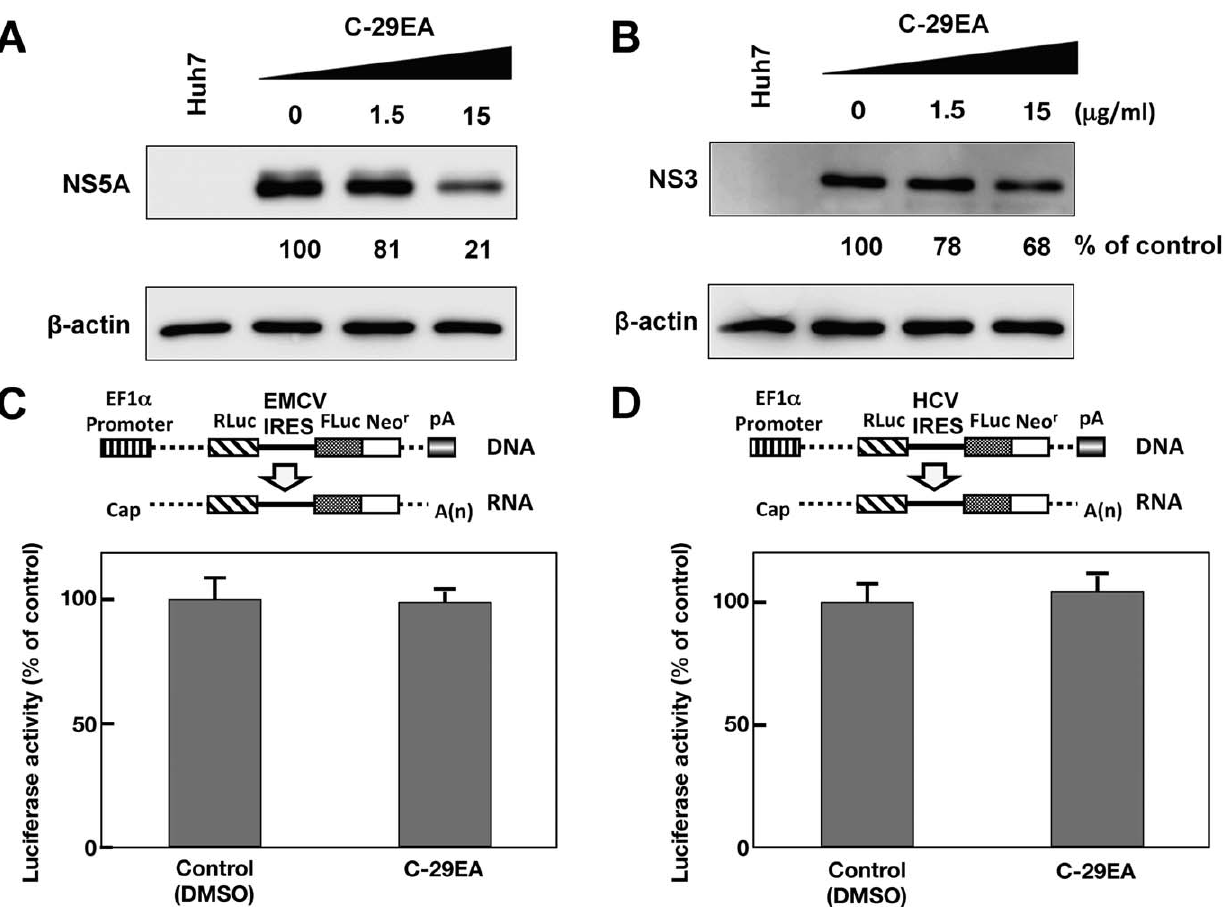
Figure 3. Effect of C-29EA on expression of viral proteins in replicon cell lines. The Huh7 replicon cell lines derived from genotype 1b (A) and 2a (B) were incubated with C-29EA at 37 u C for 72 h. The treated cells were harvested and then subjected to Western blotting. Treatment with DMSO corresponds to ‘0 9 . The bicistronic gene is transcribed under the control of the elongation factor 1 a (EF1 a ) promoter. The upstream cistron encoding Renilla luciferase (RLuc) is translated by a cap-dependent mechanism. The downstream cistron encodes the fusion protein (Feo), which consists of the firefly luciferase (Fluc) and neomycin phosphotransferase (Neo r ), and is translated under the control of the EMCV IRES (C) or HCV IRES (D). The Huh7 cell line transfected with the plasmid (each above the panel in C and D) was established in the presence of G418. The cells were incubated for 72 h without (control) and with 15 m g/ml of C-29EA. Firefly or Renilla luciferase activity was measured by the method described in Materials and Methods and was normalized by the protein concentration. F/R: relative ratio of firefly luciferase activity to Renilla luciferase activity. F/R is presented as a percentage of the control condition. Error bars indicate standard deviation. The data represent three independent experiments.